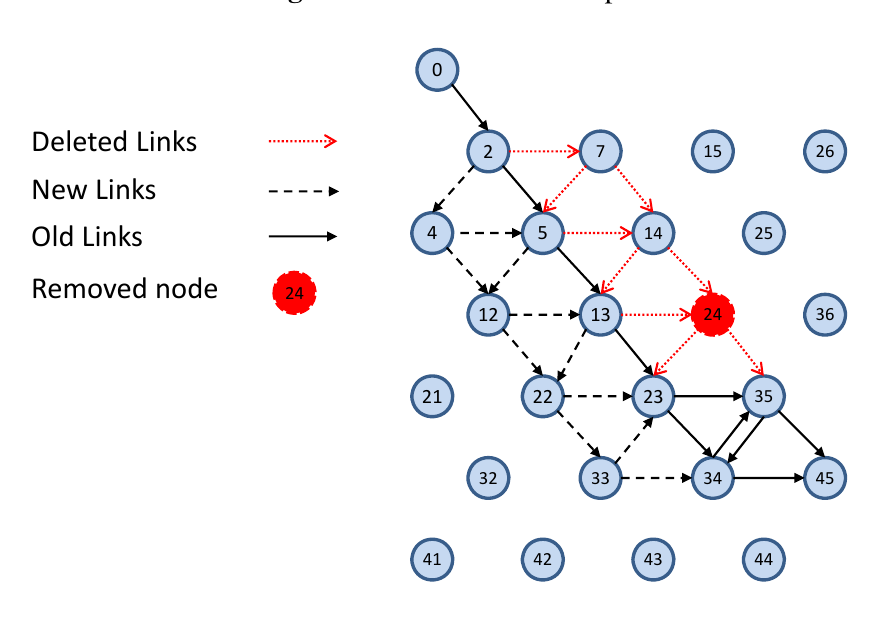
Figure 22. Node failure sample.